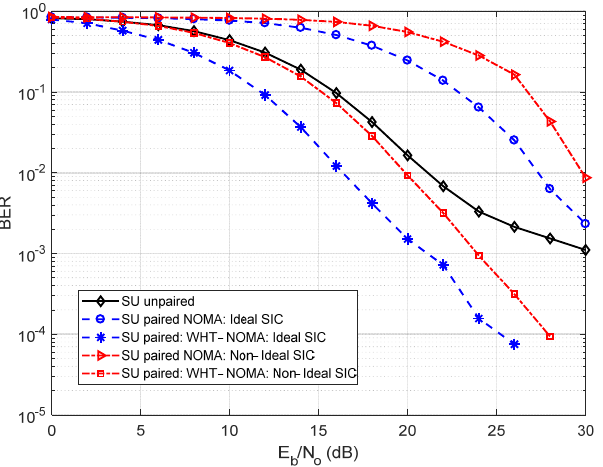
Figure 9. BER performance using 8–QAM modulation; NOMA vs. WHT–NOMA, power allocation: